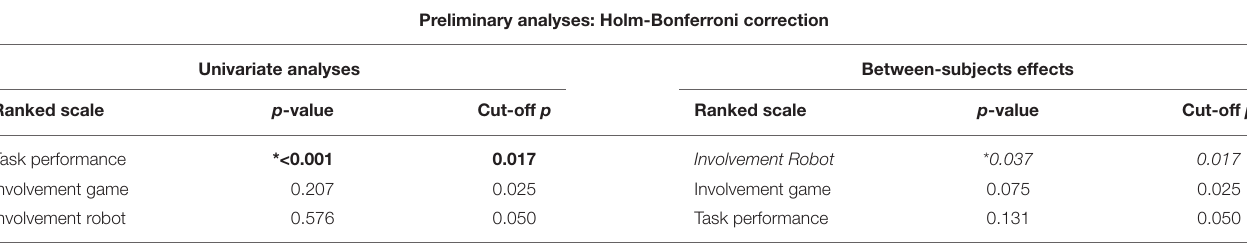
TABLE 5 | Ranked p -values for the univariate analysis and between-subjects effects referring to the preliminary analyses with corresponding cut-off p -values due to Holm-Bonferroni correction.